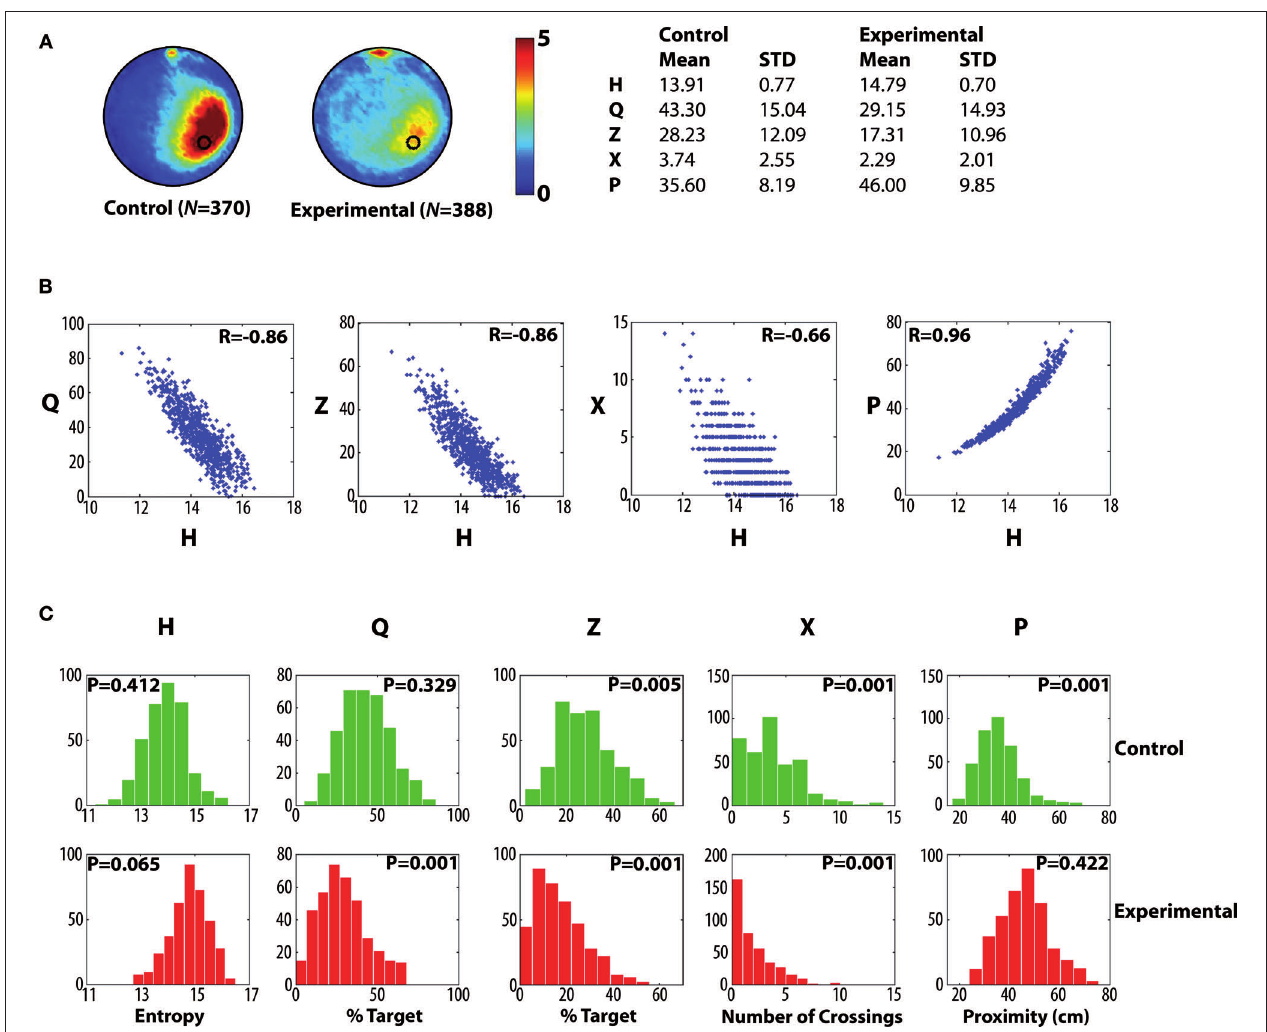
FIGURE 3 | Pooled probe test data for control and experimental mice for Analysis A . (A) Left, density plots for grouped data showing where control and experimental mice concentrated their searches in the probe test. The color scale represents the mean number of visits per animal per 5 cm × 5 cm area. Right, summary of descriptive statistics (mean values, standard deviations) for the entropy ( H ), quadrant ( Q ), zone ( Z ), crossing ( X ) and proximity ( P ) measures for control and experimental datasets. (B) Scatterplots showing